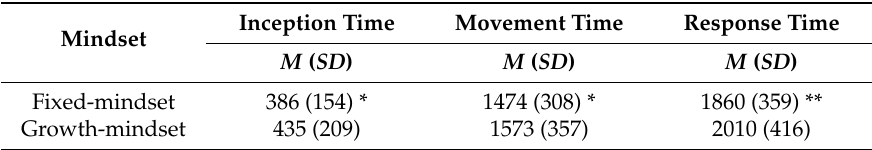
Table 1. Inception, move and response times.